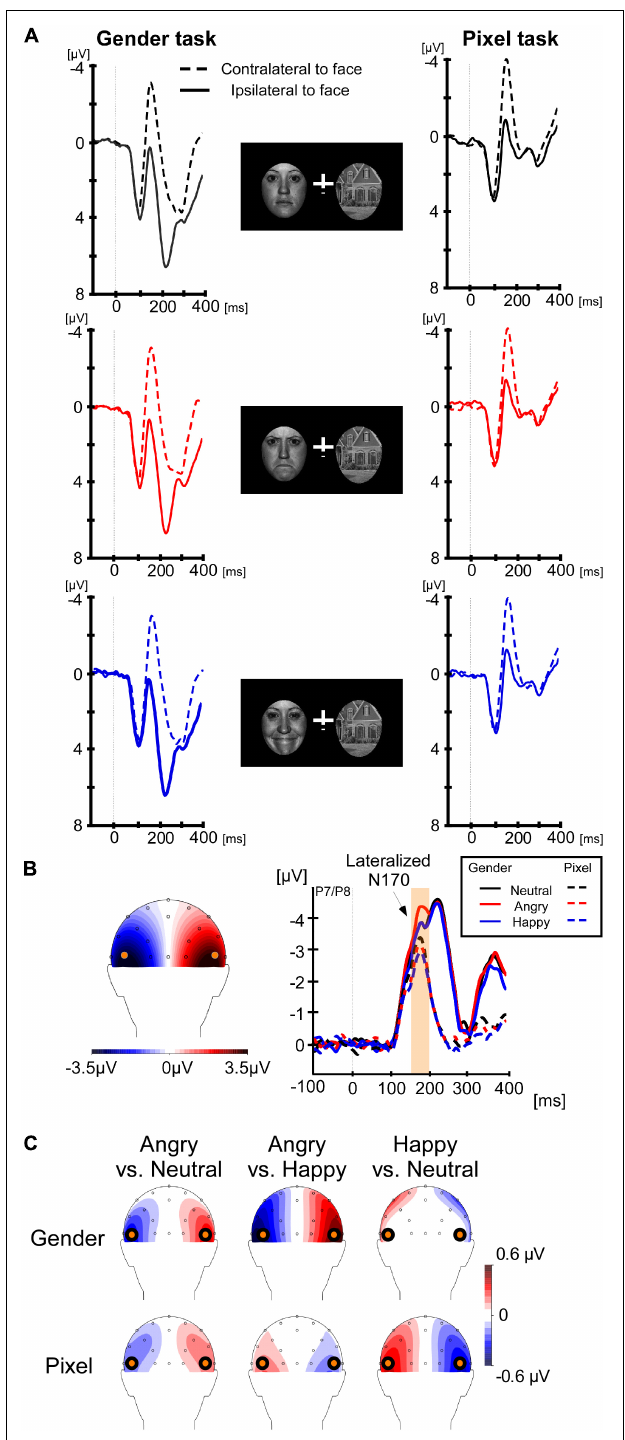
FIGURE 1 | Lateralized event-related components at P7/P8. The interval for baseline correction was from –200 to 0 ms, but only the final 100 ms are shown in the graph to save space. (A) Contralateral (dashed line) and ipsilateral (solid line) event-related potentials to the face stimuli are shown for the gender categorization task on the left and for the pixel task on the right.